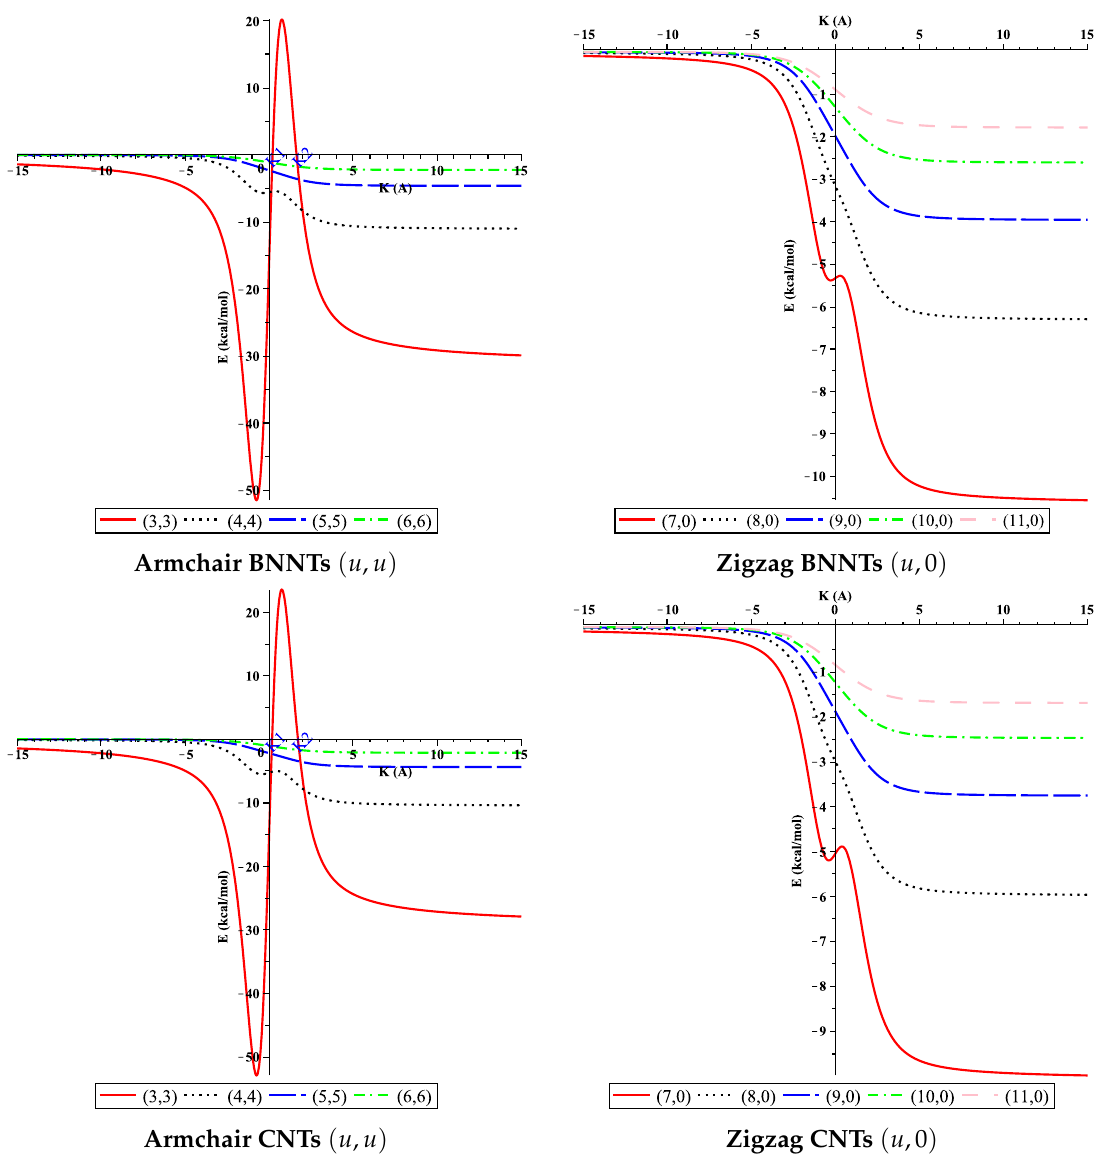
Figure 2. Typical interaction energy, showing a Fe atom accepted for all tubes and rejected for ( 3,3 )